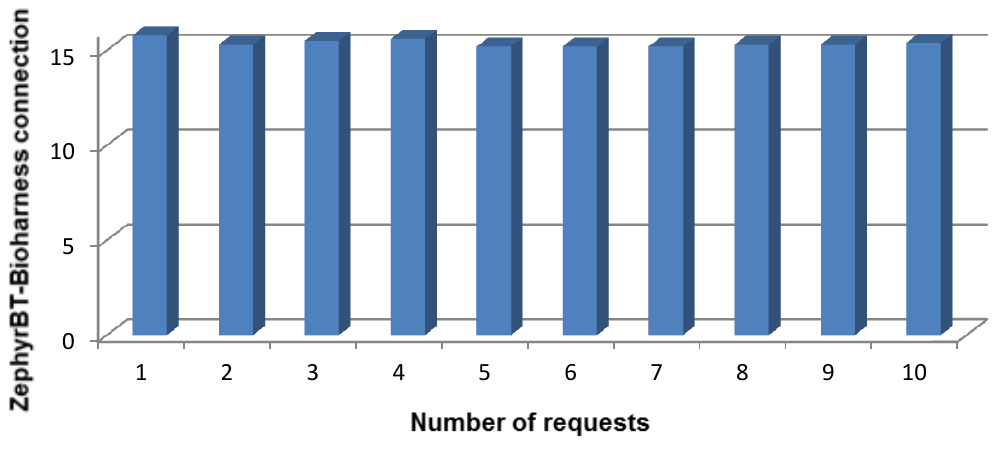
Figure 27. Time used in establishing a ZephyrBT-Bioharness connection (10 attempts).